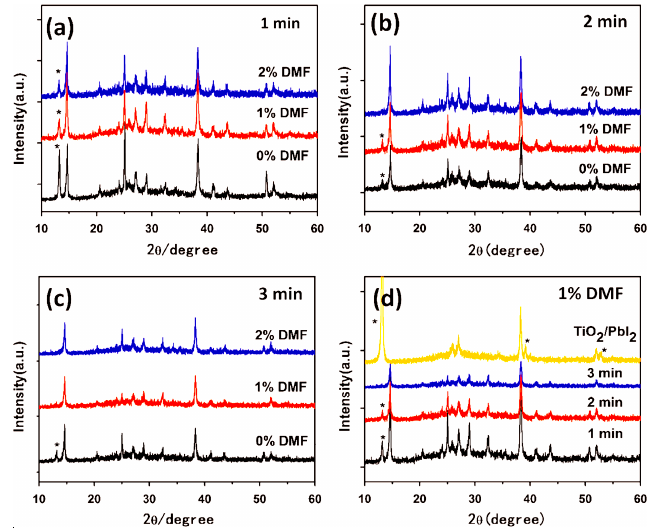
Figure 5. Effect of the ratio of DMF and dipping time on XRD patterns ( a ) 1 min; ( b ) 2 min; ( c ) 3 min; and ( d ) different dipping time with 1% DMF [76]. Copyright © 2015, Elsevier.